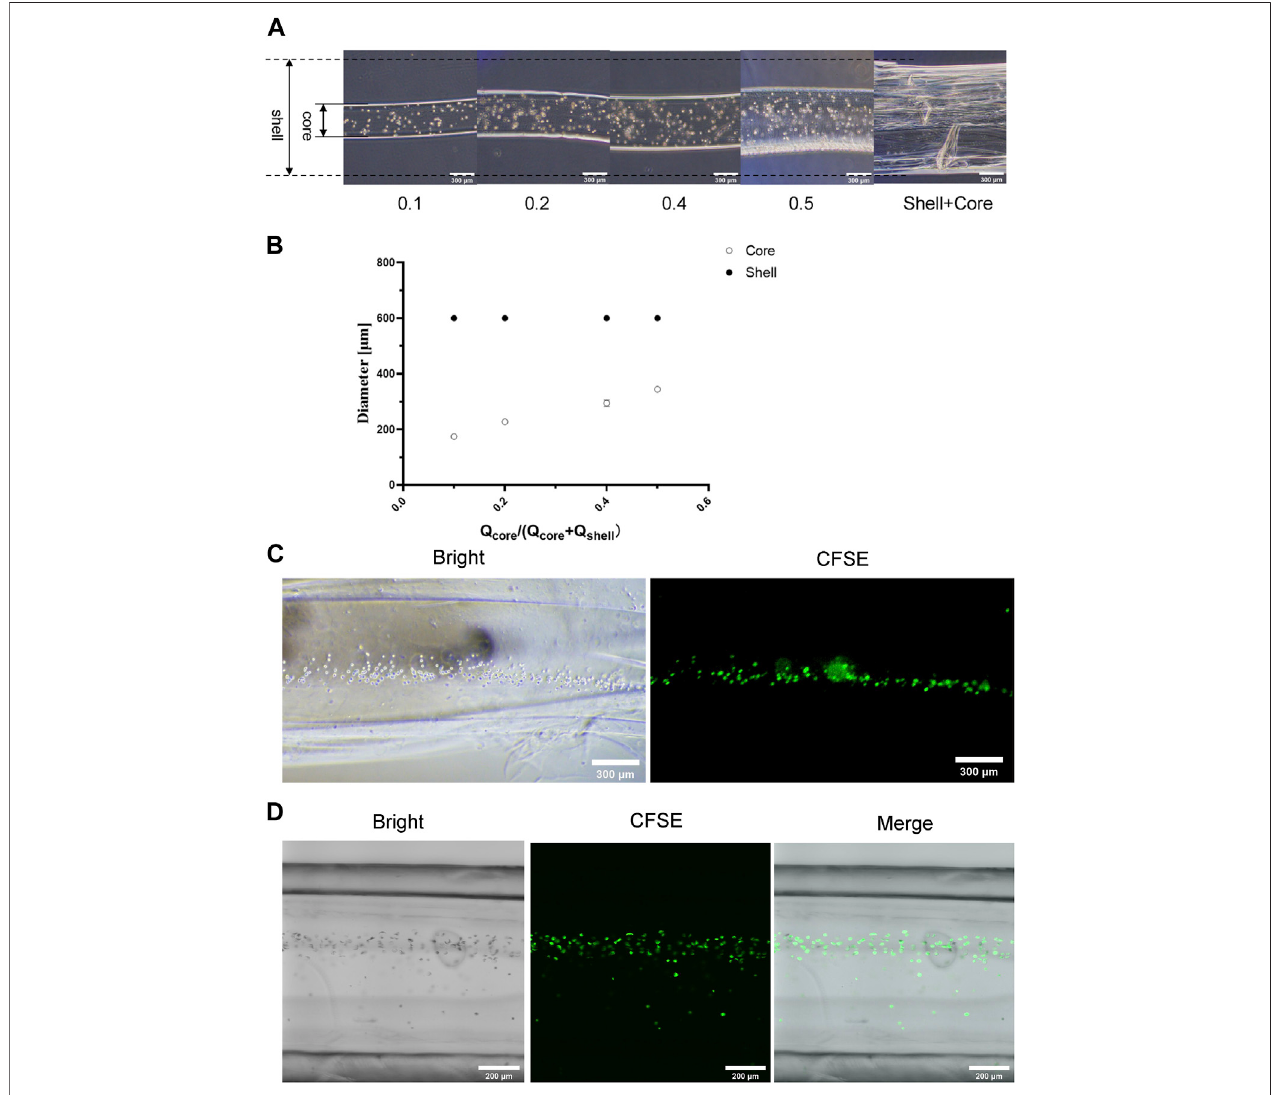
FIGURE 5 | Structure Characterization of Cell Filament (A) Microscopic images of formed cell fi laments under different fl ow ratios, the scale is 300 μ m (B) The relationshipbetweenthediameteroftheformedcell fi lamentandthe fl owratio (C) Microscopeimagesofthecell fi lamentsdistributionincalciumalginatemicrotubes,the